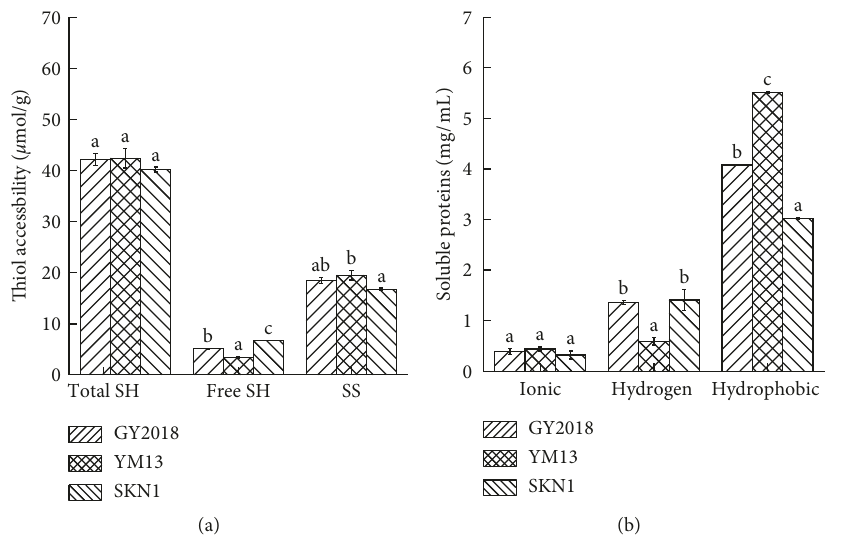
Figure 7: Intermolecular forces in GY2018, YM13, and SKN1.Total SH, free SH, and SS content in samples (a). Ionic, hydrogen, and hydrophobic interactions in samples (b). Different lowercase letters indicated significantly different between the same intermolecular forces with different varieties ( p < 0 .